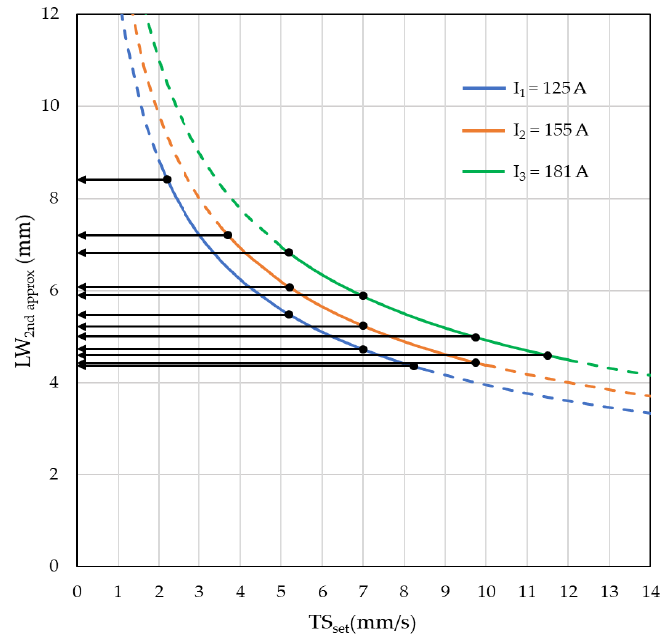
Figure 14. Determination of the layer width and, consequently, the substrate thicknesses for each of the experiments.